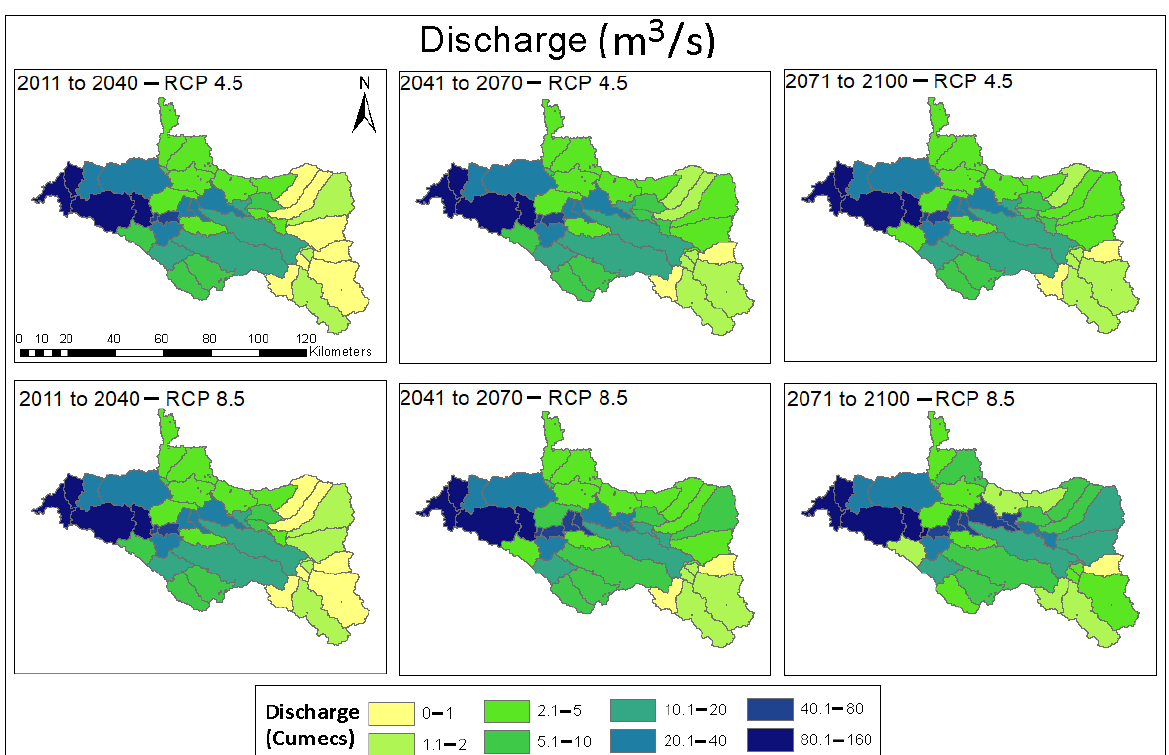
Figure 12. Spatial distribution of streamflow for near, mid-, and far future of RCP 4.5 and 8.5 emission scenarios .